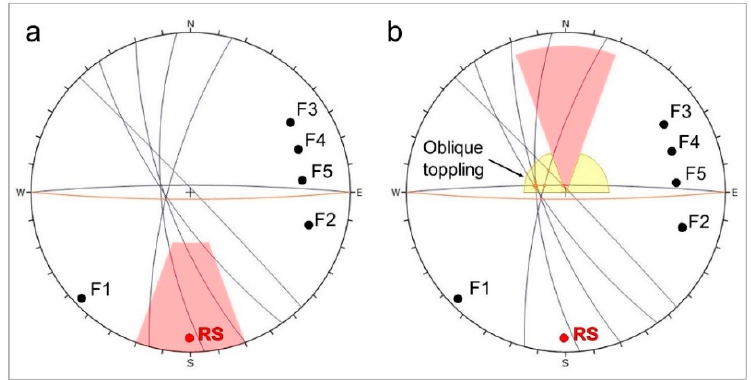
Figure 17. Toppling analysis at San Leo using first-order geological structures and the rear release surface (RS) formed during the slope failure. ( a ) Flexural toppling envelop. F2–F5 may potentially act as lateral release surfaces; ( b ) Direct toppling envelop. Intersections plotting in the yellow area are susceptible to oblique toppling.